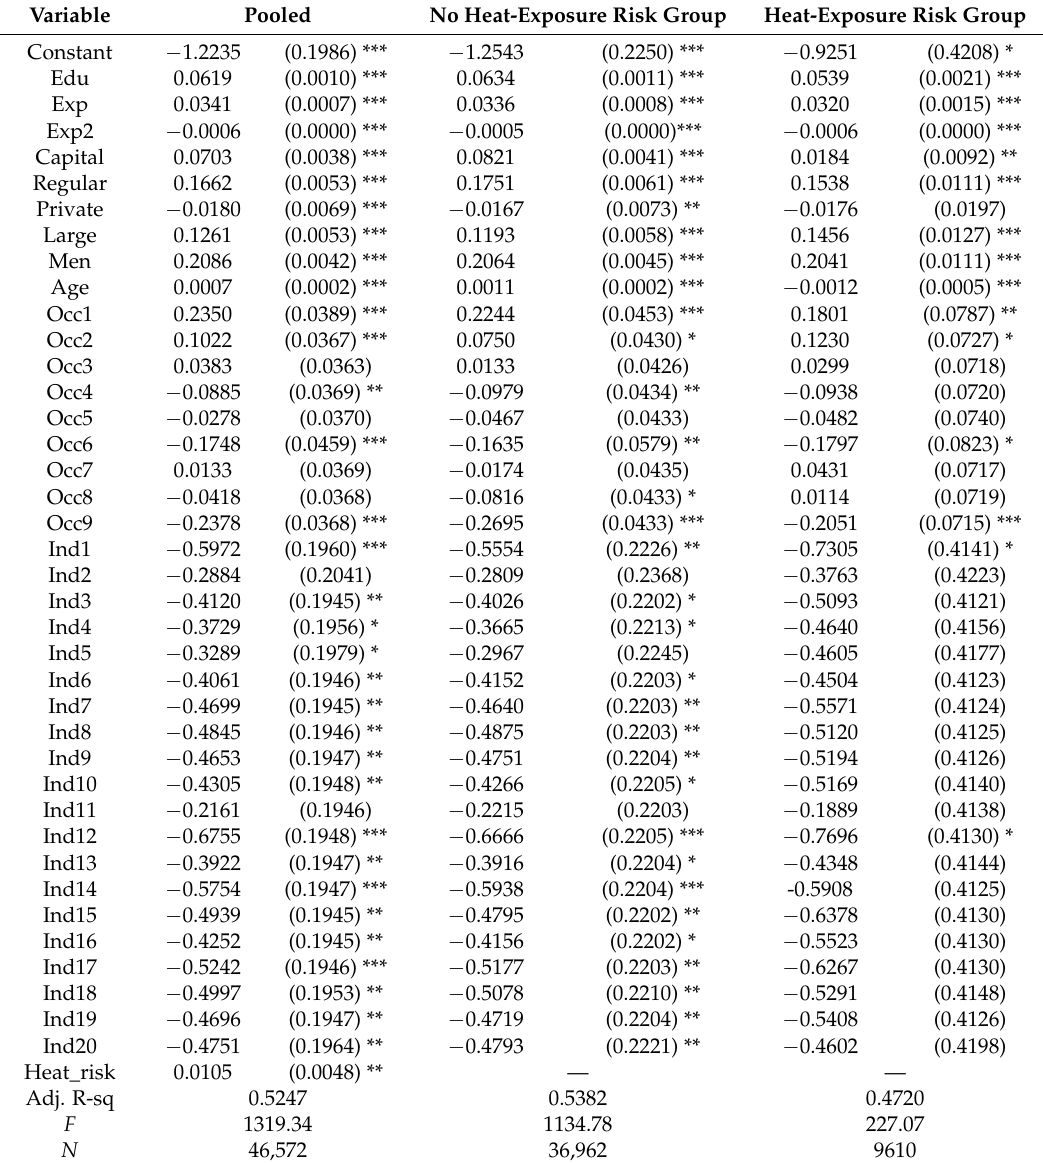
Table 3. Estimated result of the wage